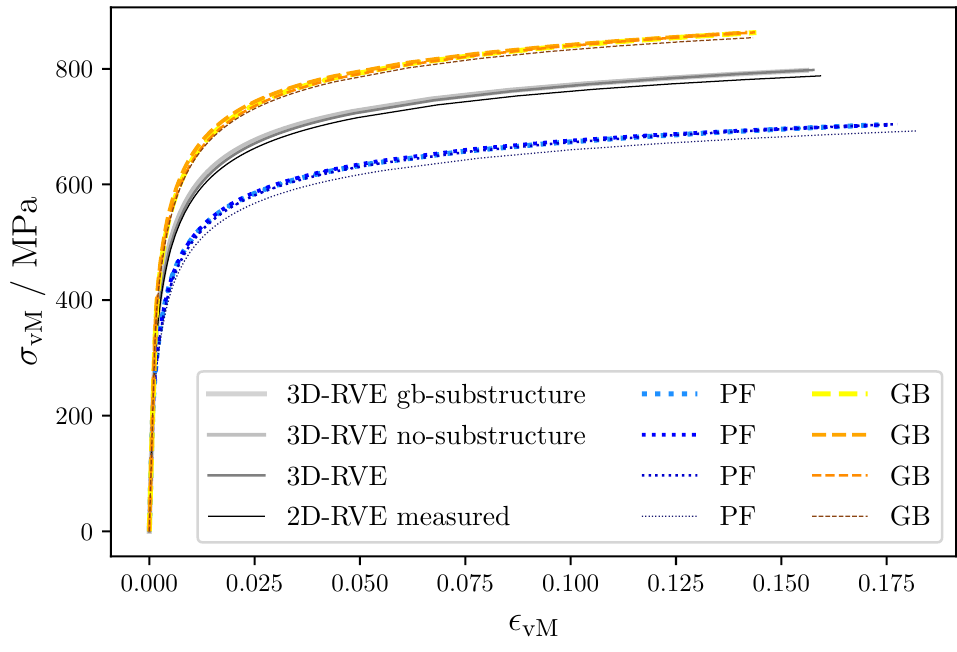
Figure 8. Macroscopic stress–strain curves for the different RVEs used in this work. Polygonal ferrite is shown in blue and granular bainite is shown in in